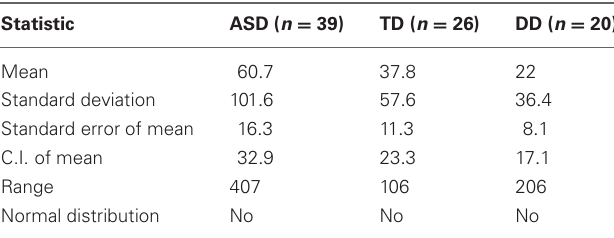
Table 3 | Descriptive statistics for the place of articulation contour areas of ASD, TD, and DD